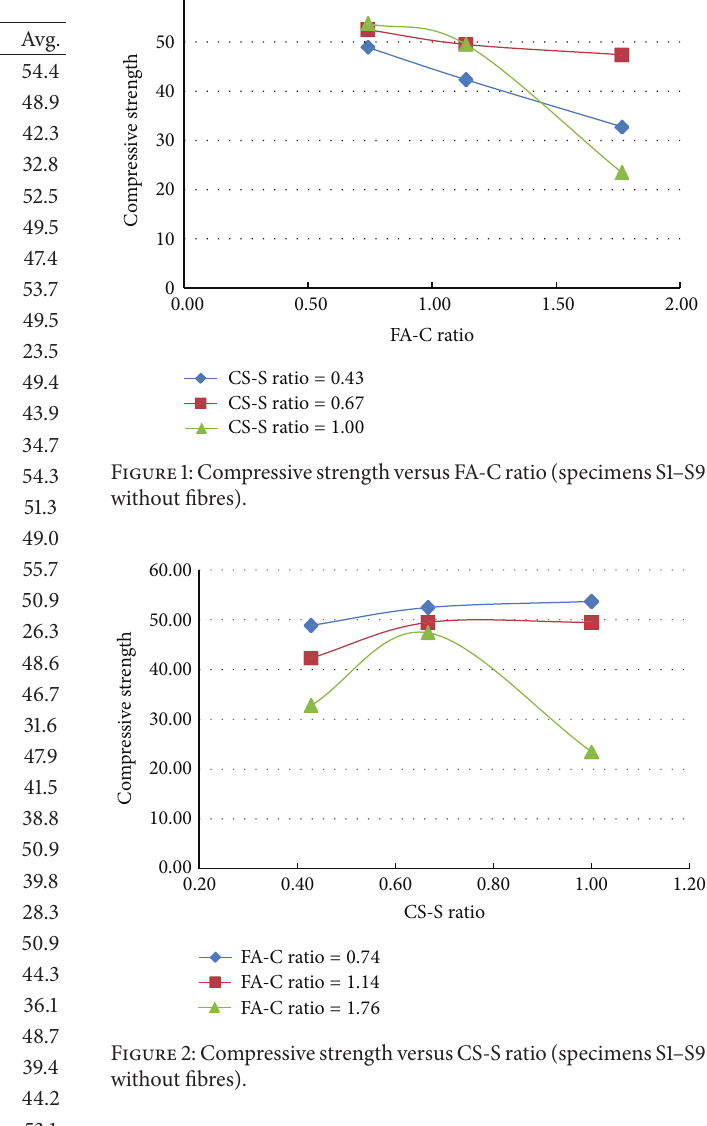
Table 2: Compressive strength (28-day) of specimens.